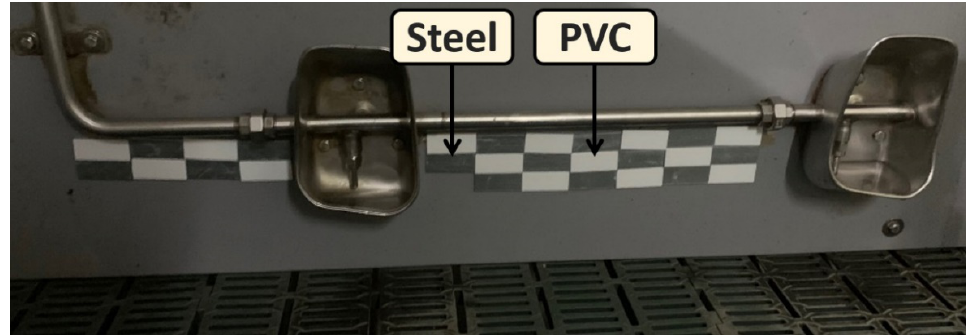
Figure 1. Arrangement of coupons on the wall. Steel and PVC coupons were placed on the walls under the water lines using double-sided tape in a staggered arrangement.